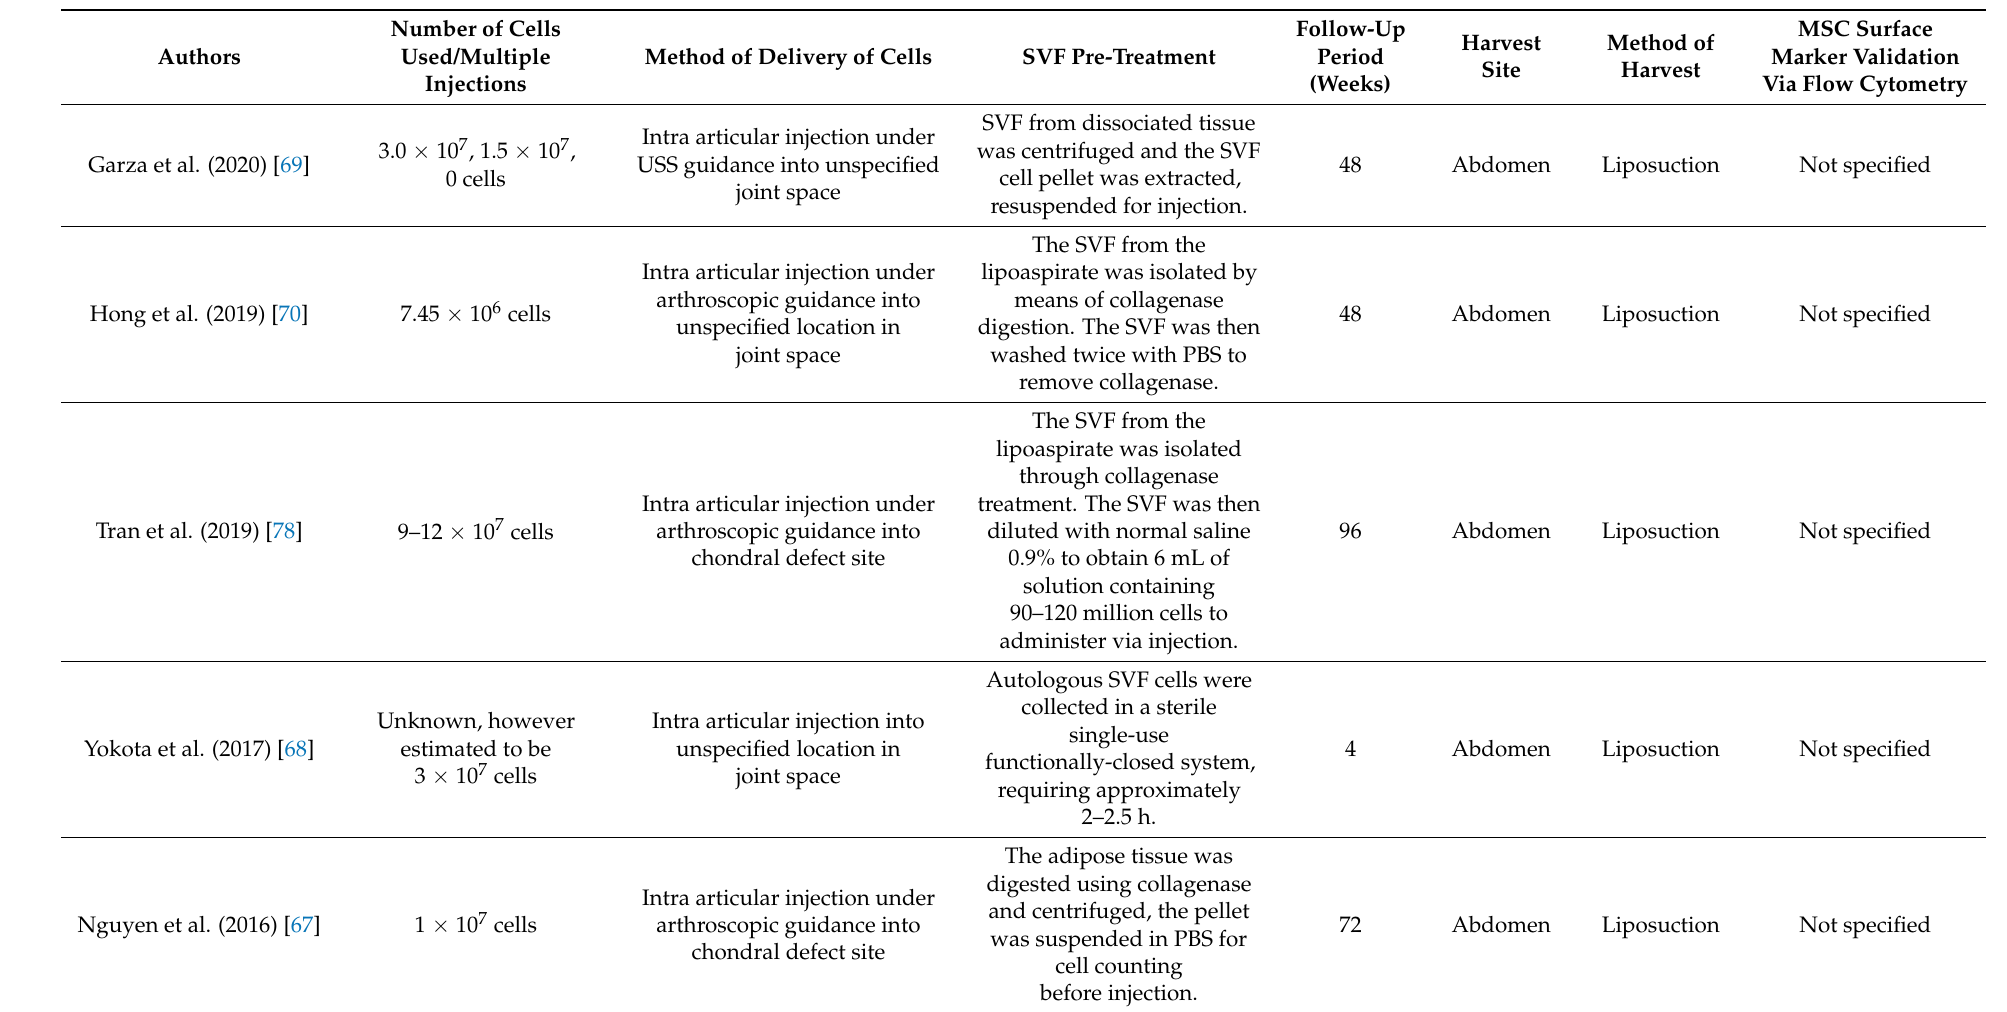
Table 4. Cellular characteristics for SVF studies, n =